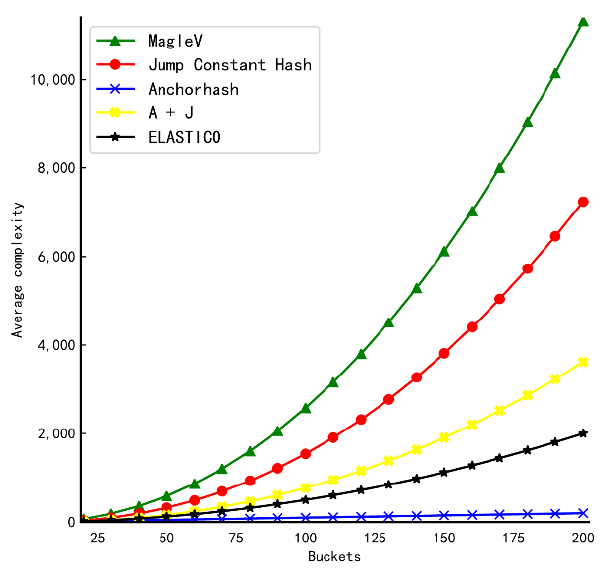
Figure 12. Average time complexity.